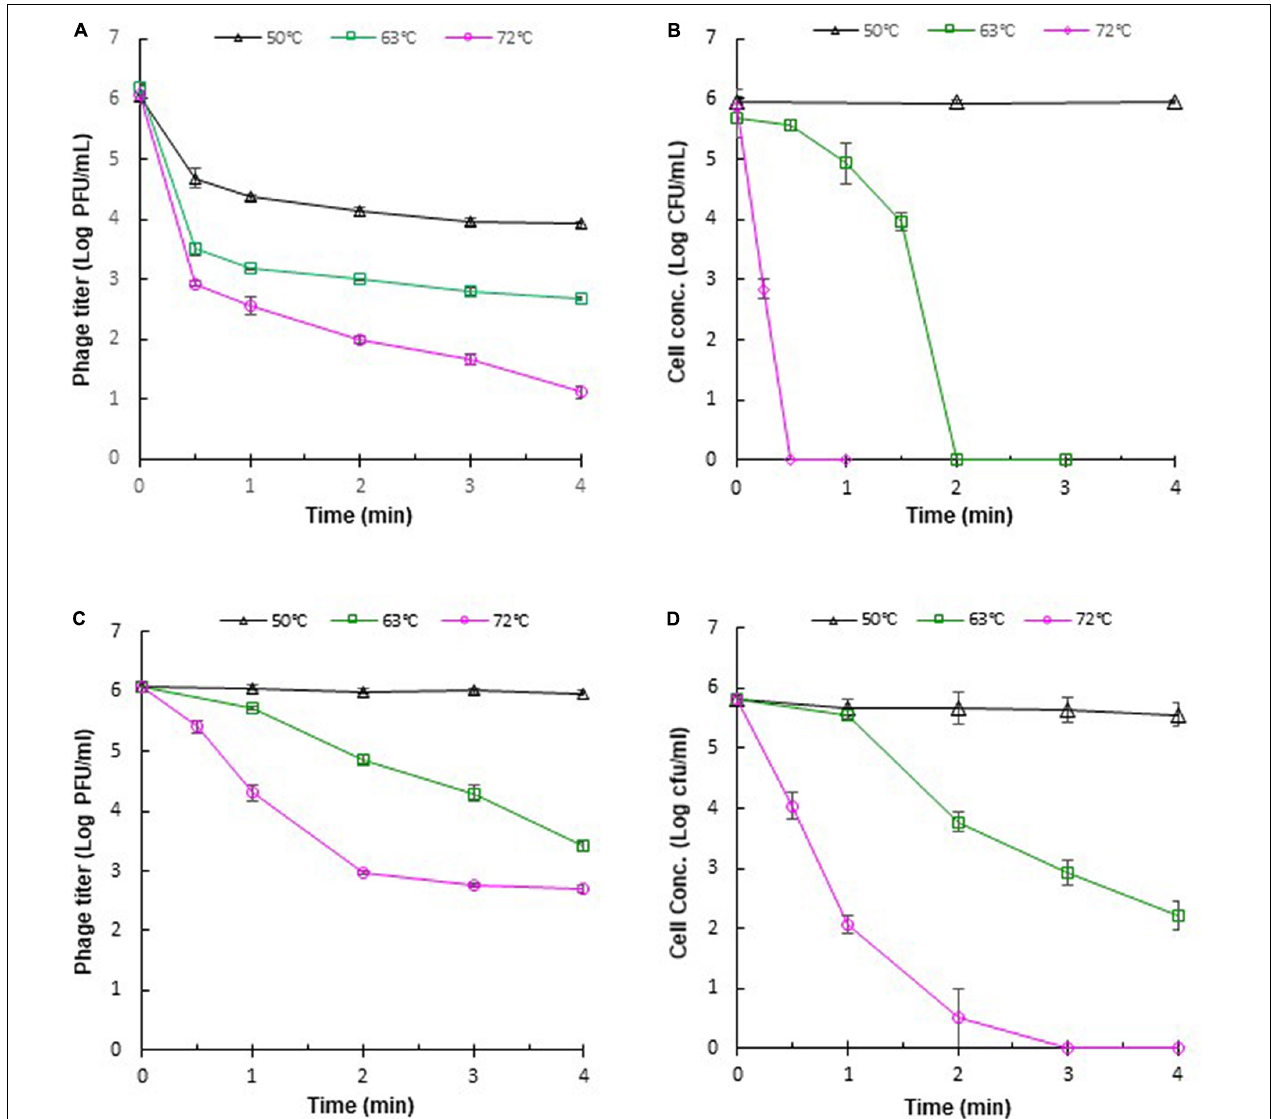
FIGURE 5 | Thermal stabilities of Salmonella phage (cid:56) Ent and its host Salmonella Thompson in saline ( A,B , respectively) and in TSB ( C,D , respectively). Error bars indicate the standard error of the mean.